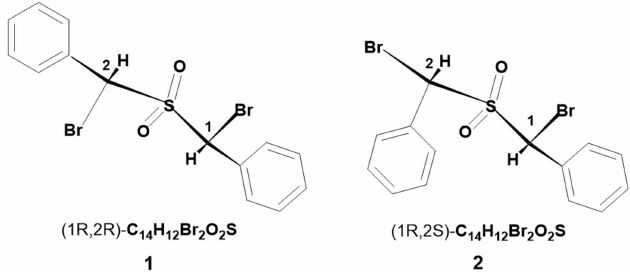
Figure 1 The two diastereoisomers, 1 and 2 , of PhCHBr (cid:2) SO 2 (cid:2)